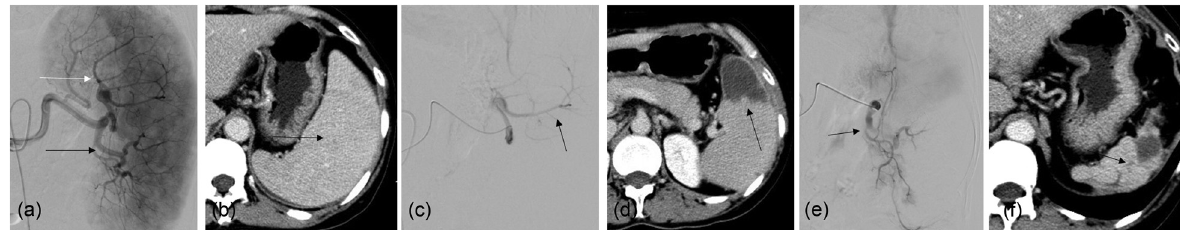
Figure 2: A 65 - year - old woman with hepatitis B cirrhosis and hypersplenism underwent twice PSE. ( a ) Digital arteriography showed superior splenic artery branch ( arrow ) and inferior pole splenic artery branch ( hollow arrow ) . ( b ) Splenomegaly ( arrow ) . ( c ) First embolization of superior splenic artery ( arrow ) . ( d ) One month after the fi rst PSE, low - density infarct area was found in spleen ( arrow ) . ( e ) The second PSE embolized the inferior splenic artery ( arrow ) . ( f ) One year later, the spleen shrank ( arrow )